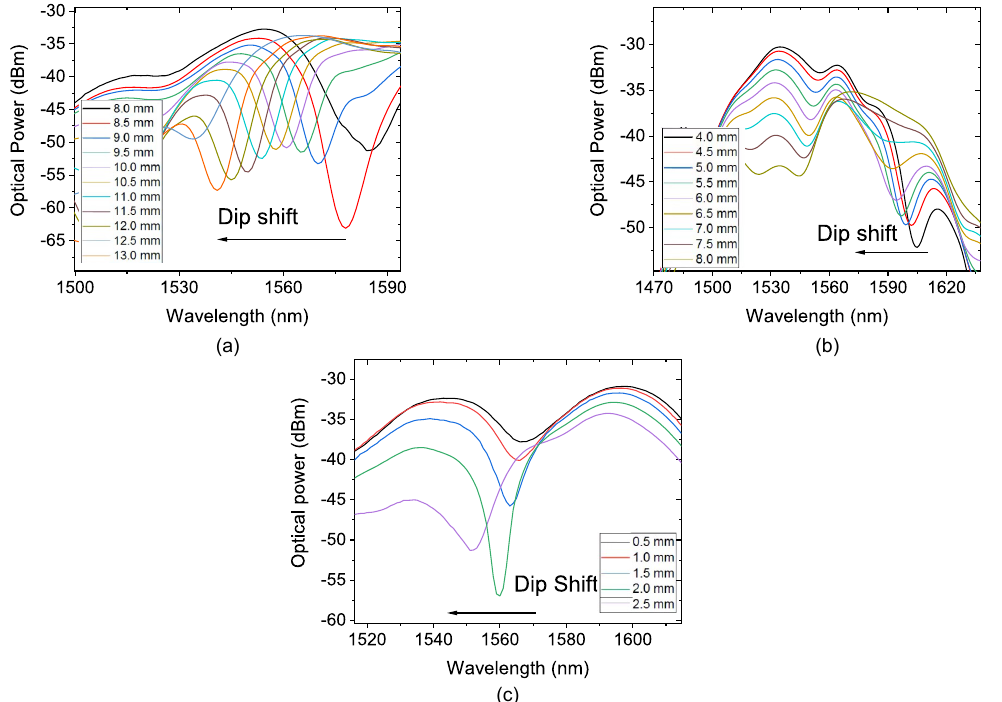
Figure 8. Transmission spectrum of the sensor with D S = 80 mm and ( a ) the sensor with FP = 5 mm; ( b ) the sensor with FP = 10 mm; ( c ) the sensor with FP = 15